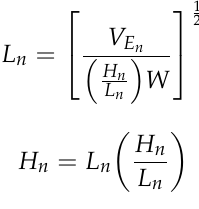
Figure 8. Elevation of the free water surface: ( A ) all simulation times; ( B ) detail of 100 s  t  150 s.